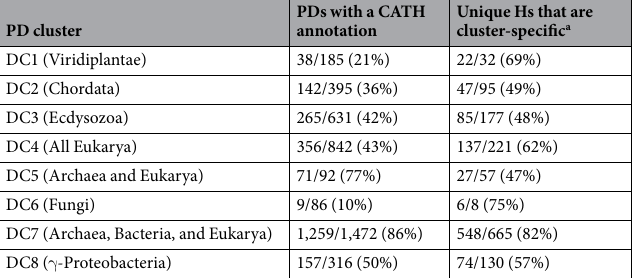
Table 3. Cluster-specific homologous superfamilies (Hs) in the eight PD clusters. a Ratio (%) of cluster-specific homologous superfamilies to the total number of unique homologous superfamilies for PDs with a CATH